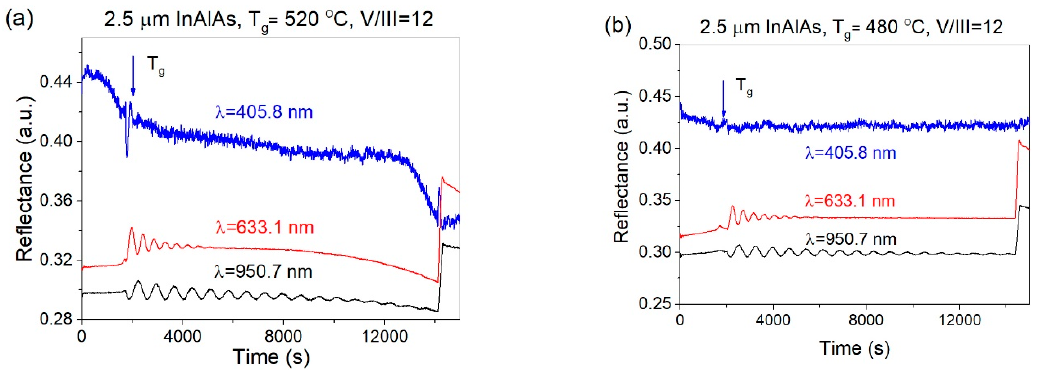
Figure 3. Optical reflectance signals recorded during growth of 2.5 µm thick In 0.52 Al 0.48 As layers: ( a ) T g = 520 °C, V/III = 12 and ( b ) 480 °C, V/III = 12.